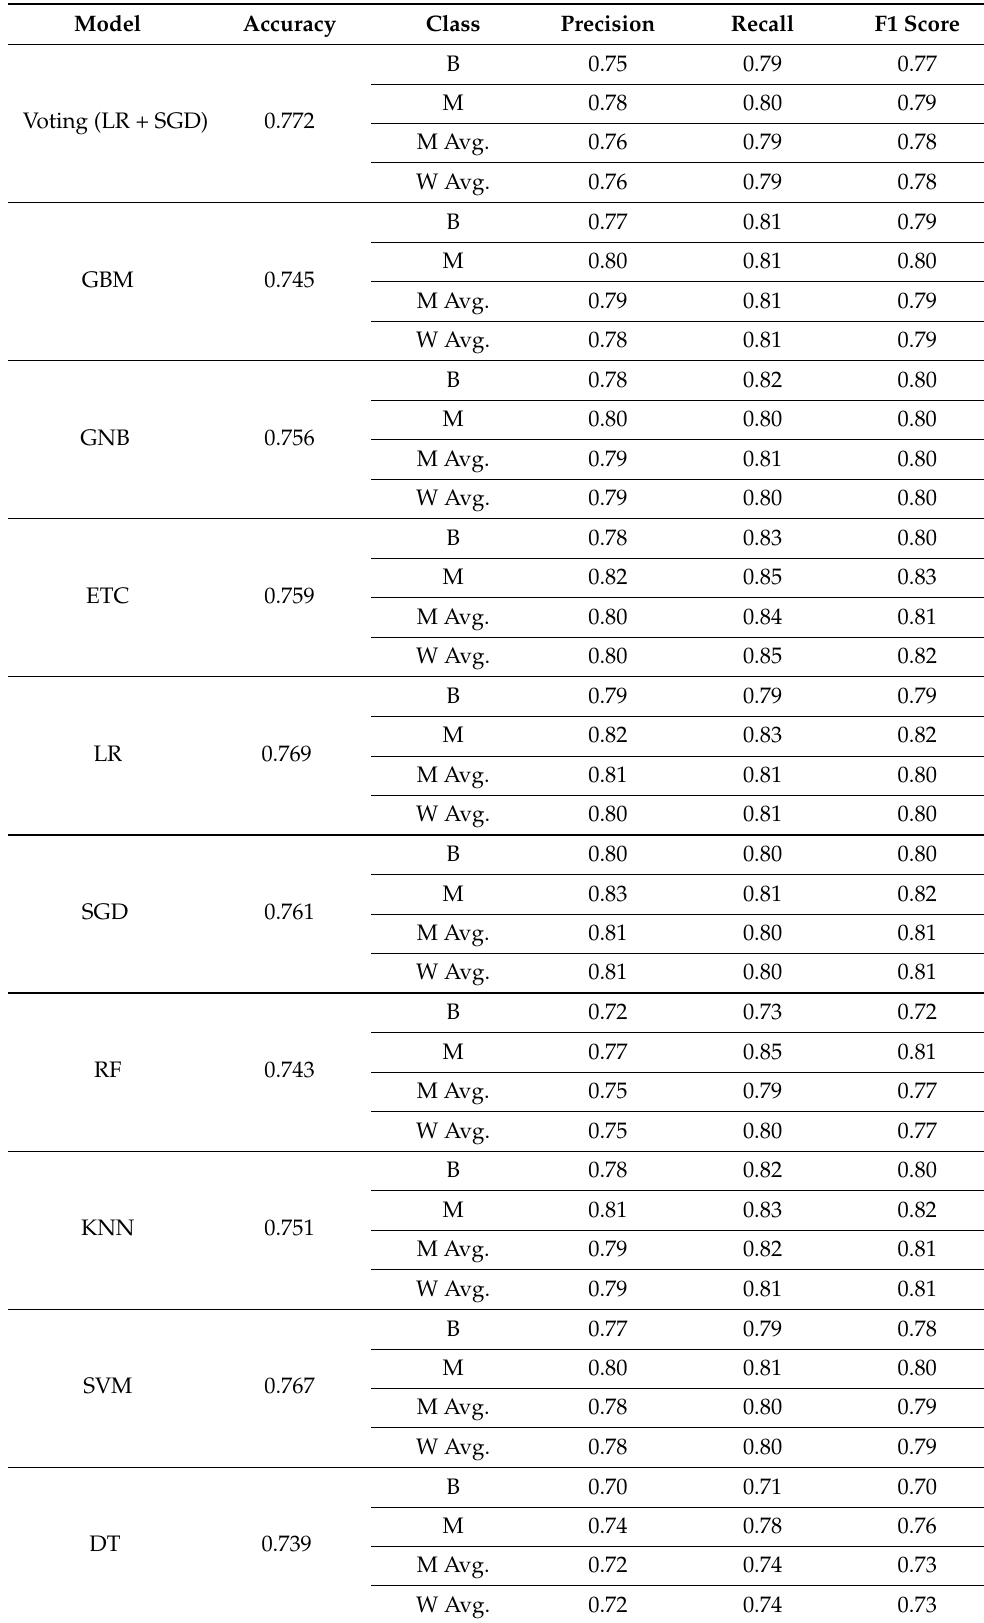
Table 4. Performance of machine learning models using the original